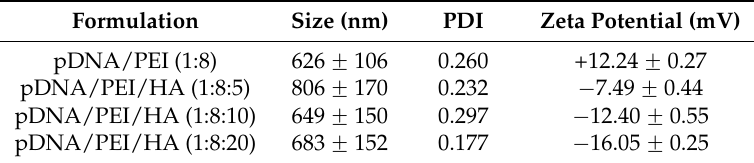
Figure 2. SEM images of ( a ) pDNA/PEI; and ( b ) pDNA/PEI/HA (1:8:20). Table 1. The size and zeta-potential of binary and ternary nanocomplexes.